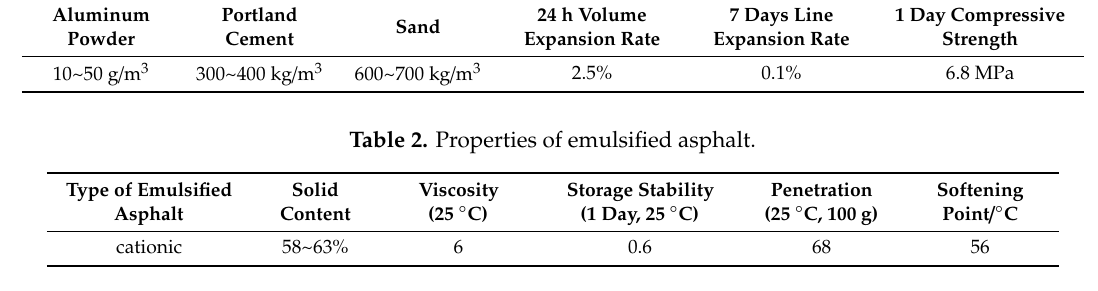
Table 3. Mix proportions of CAM